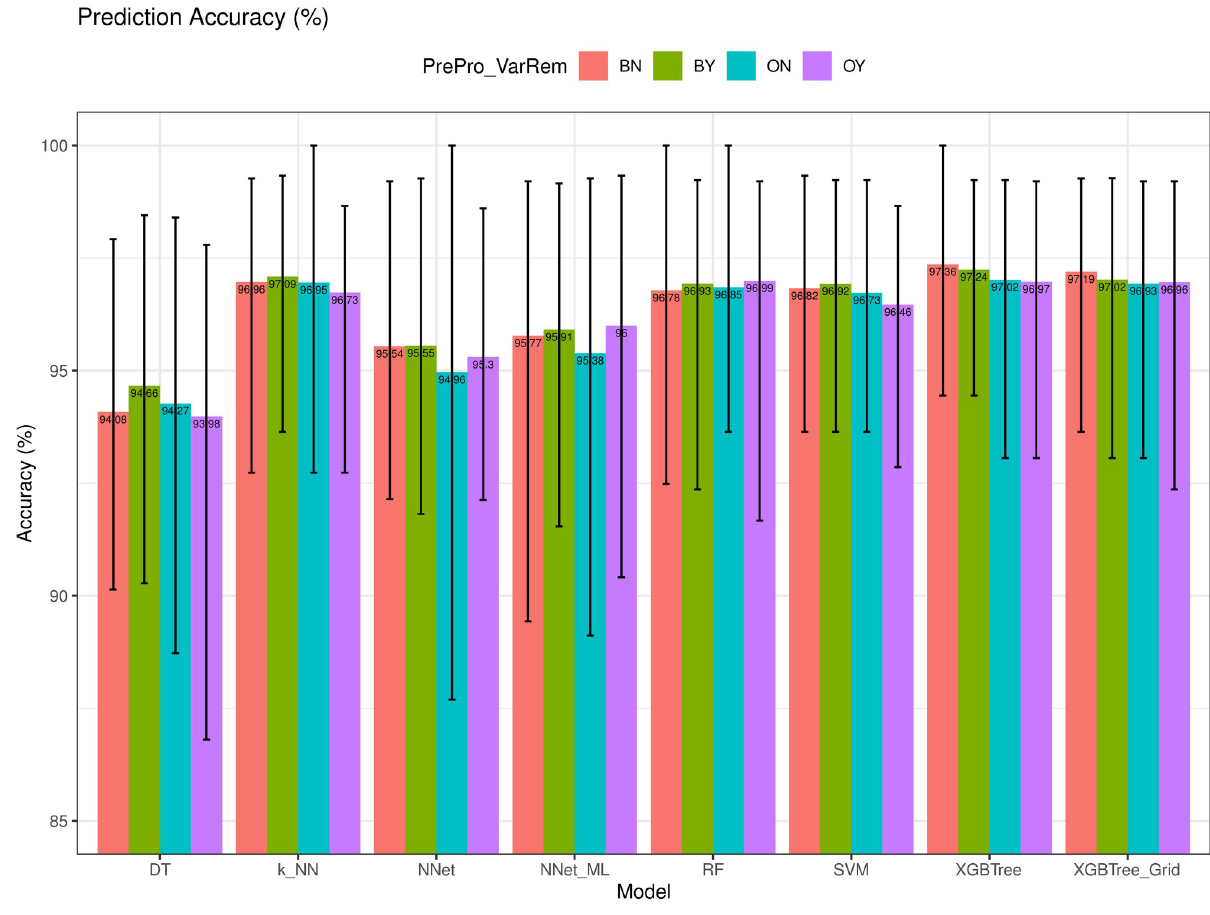
Fig 8. Prediction accuracy ( Acc ) of different